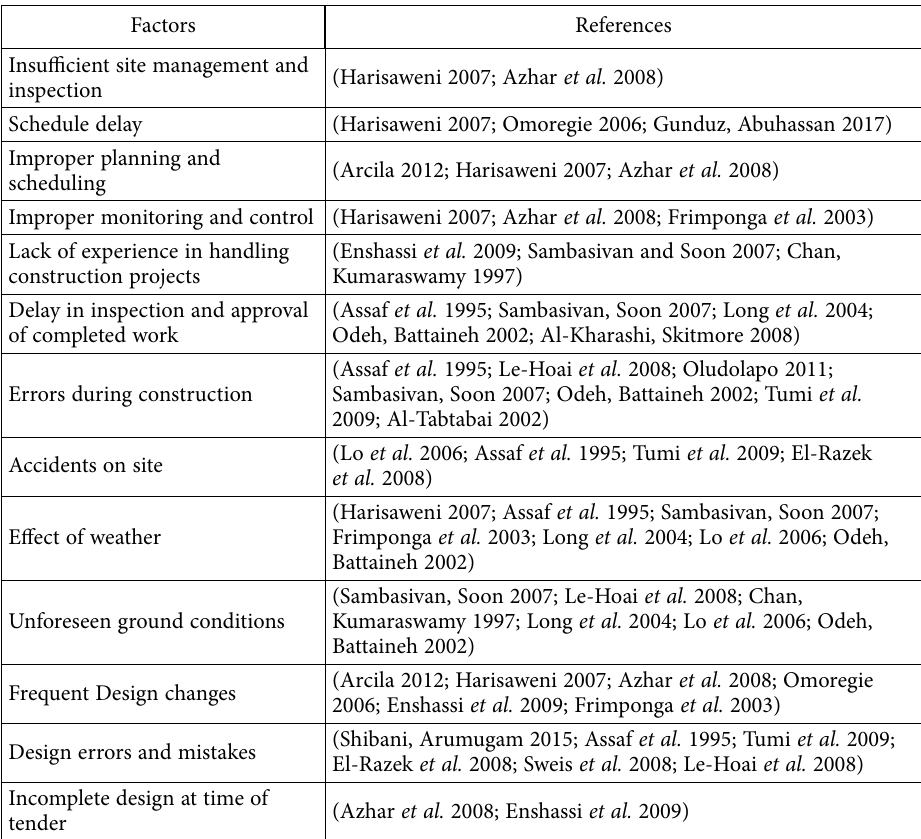
Table 1. Cost overrun